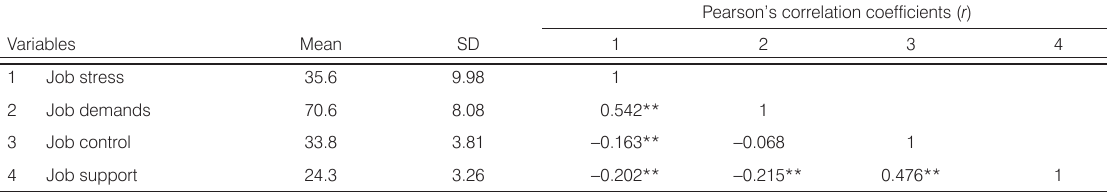
Table 2. Means, SDs and correlations for key variables ( n = 272).